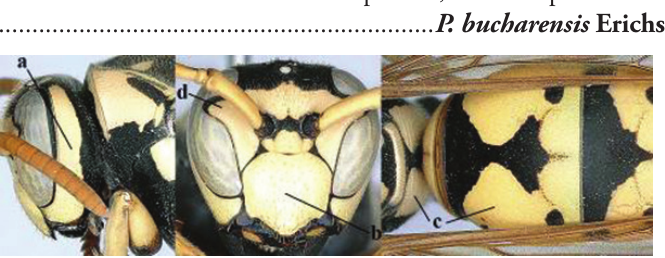
– Temple with separated yellow spots (aa), if connected then band medially narrower than half width of temple; clypeus with medial black spot, may lack in few specimens (bb); propodeum and second tergite largely black (cc); incision of eye mainly black (dd); [bristles of clypeus conspicuous]; W and C Turkey, Azerbaijan, probably also farther east in temperate Asia ....................